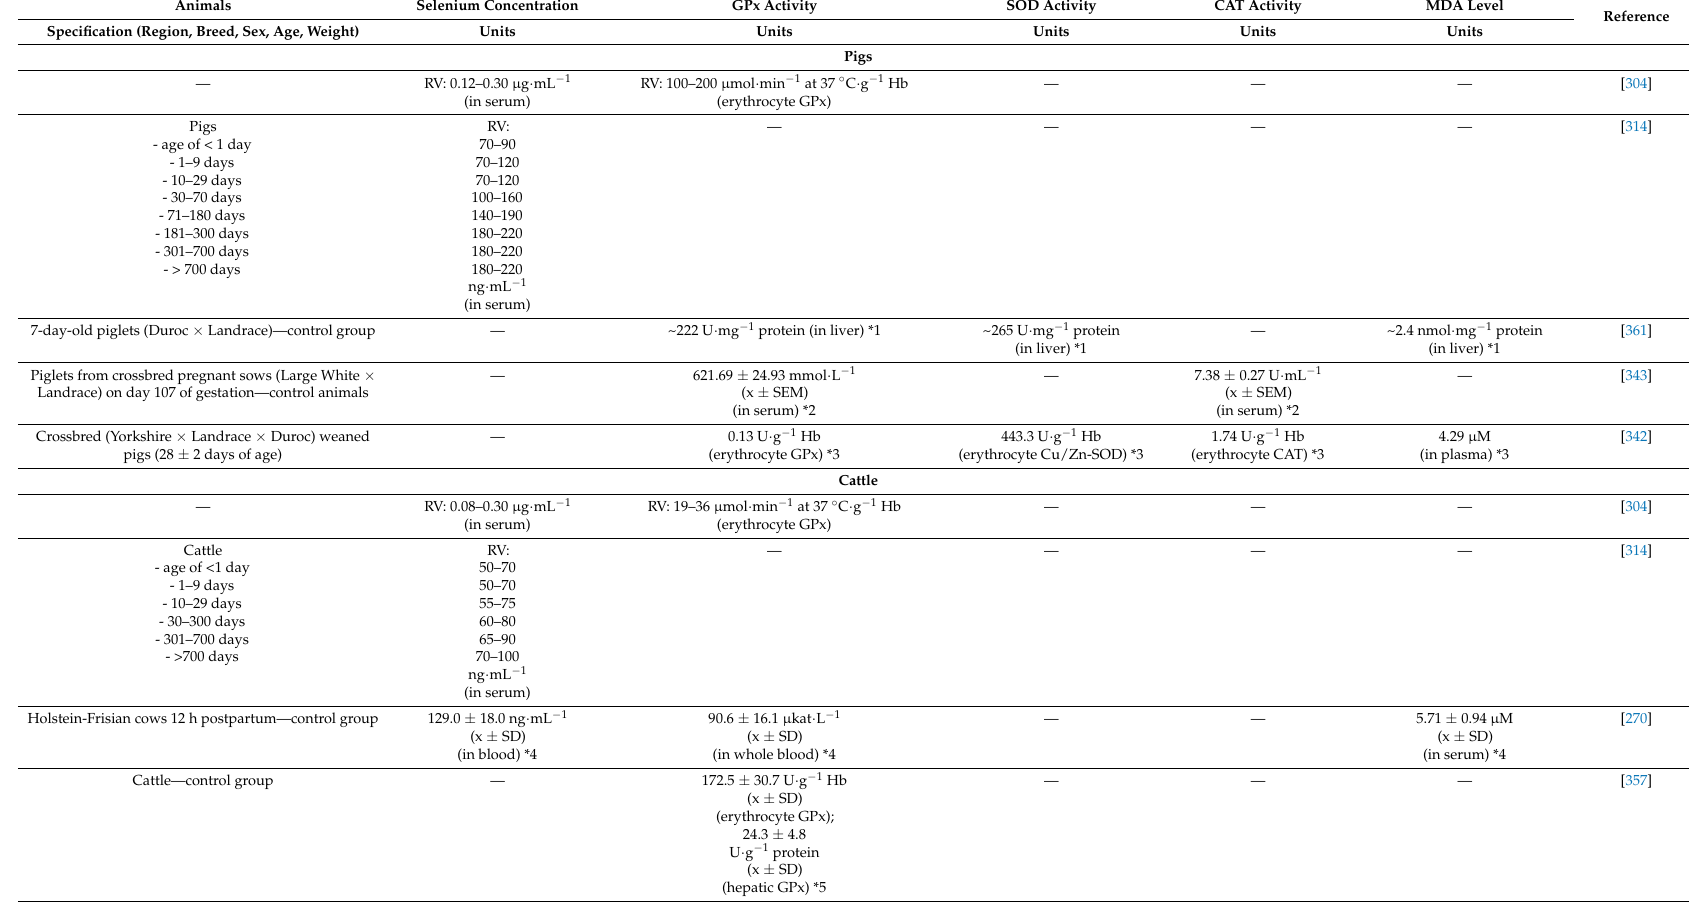
Table A1. Values of selenium concentration, GPx activity and oxidative stress parameters (SOD, CAT, MDA) in animals in different research studies, or their reference